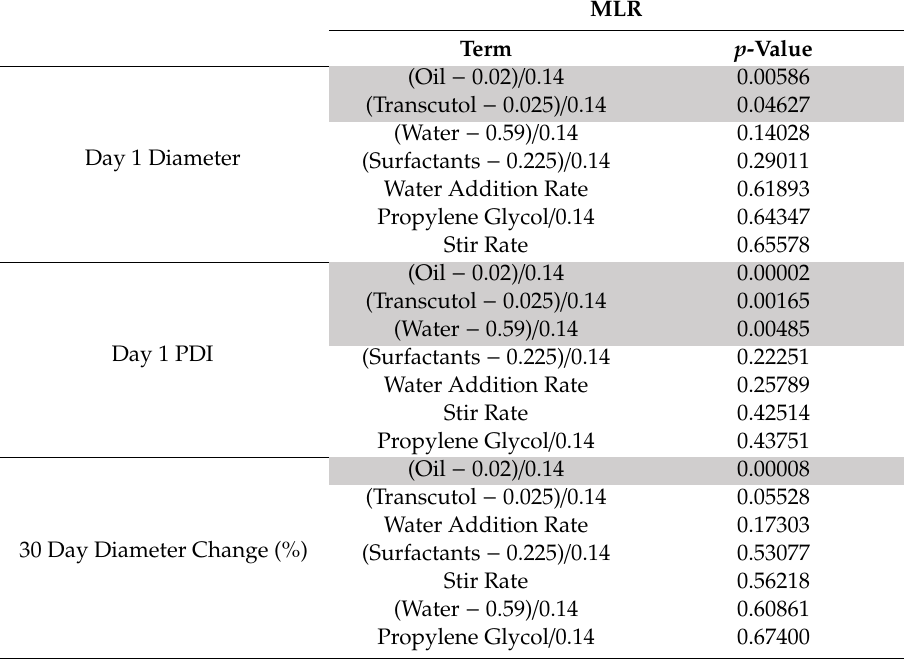
Table 7. Left: Parameters and their corresponding p -values for MLR models developed from the screening design of experiments. Significant ( p -value < 0.05) parameters are highlighted in gray. Right: Parameters and their corresponding percent contributions for boosted tree models developed from the screening design of